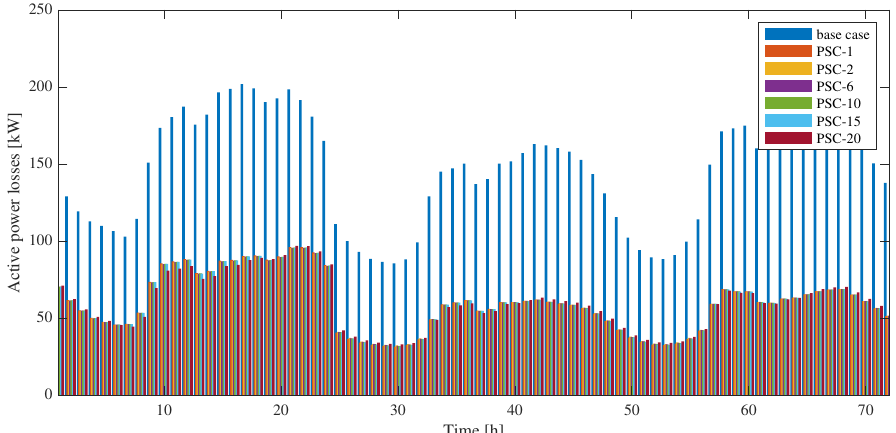
Figure 10. The active power losses for